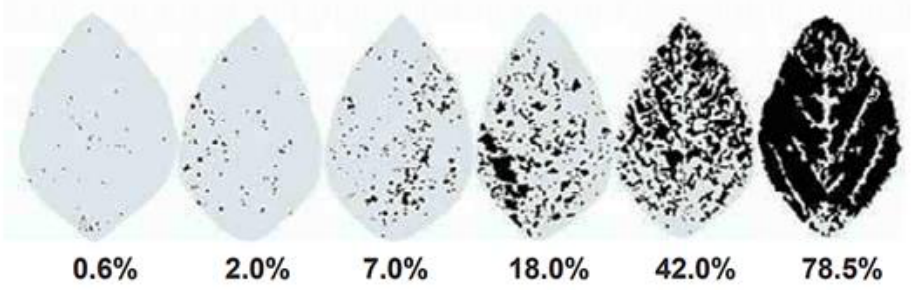
Figure 1. Diagrammatic scale proposed by Godoy et al. (2006) [34] for the severity of Asian soybean rust. Three evaluations were performed, the first one at 14 days after inoculation of the pathogen (DAI), followed by one at 18 days after inoculation, and ending with the last one at 21 days after inoculation. All evaluations were made by always observing one of the leaves of the first pair just above the cotyledonary leaves, in which one of them was randomly detached from the plant in the first evaluation.